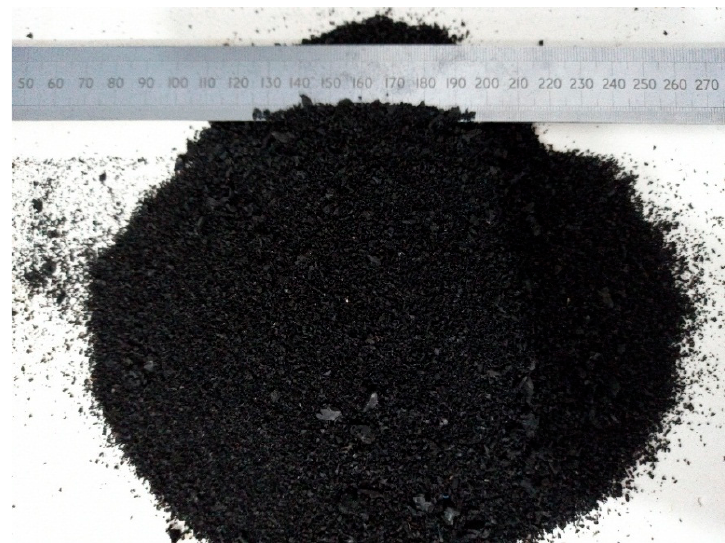
Figure 2. Crumb rubber used in the research.